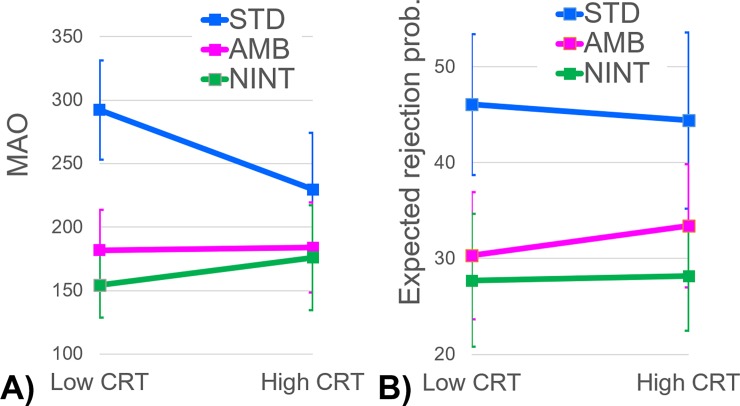
The levels of MAO (Panel A) and expected rejection probability of an unfair offer (Panel B) in the UGSTD, the UGAMB, and UGNINT
as functions of the categorized CRT. Error bars represent 95% confidence intervals in the relevant within-participant condition.